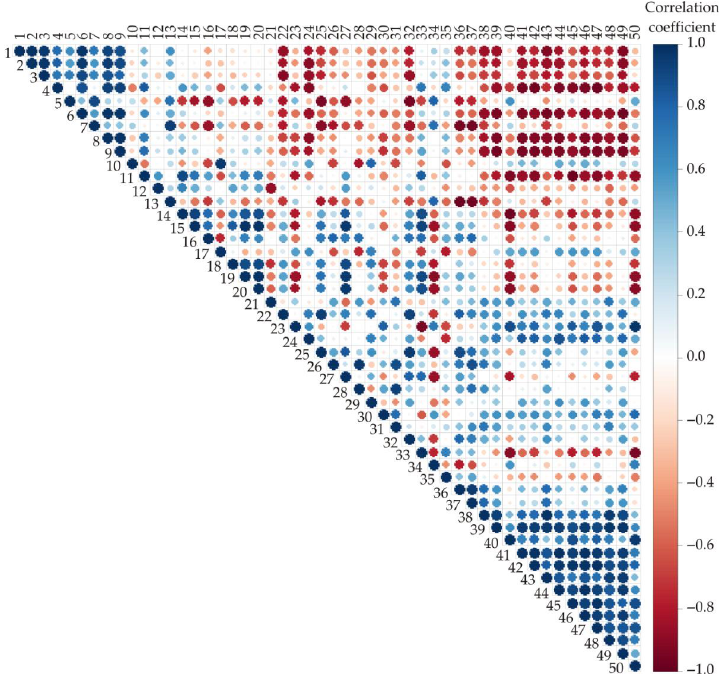
Figure 3. Color correlation diagram of active compounds content in the immortelle EO samples from 2017, 2018, and 2019 (active compounds codes are listed in Table 2). Thoroughly illustrating the observed data structure, PCA was employed, and the ac- quired results are shown in Figure 4. The first two PCs illustrated 78.7% of the total vari- ance in the experimental data. The first PC explained 45.72% and the second 32.98% of the total variance between the experimental data (Figure 4). According to the PCA analysis, a greater positive influence on the first principal com- ponent (PC1) was observed for the content of the following: α -pinene (3.2%, based on cor- relations), α -fenchene (3.2%), β -pinene (2.4%), δ -2-carene (3.9%), limonene (4.0%), γ -ter- pinene (4.1%), terpinolene (4.3%), and isoamyl tiglate (3.1%). The most prominent nega- tive influence on PC1 calculation was observed for the concentrations of the following: trans - α -bergamotene (2.3%, according to correlation), β -costol (2.4%), cis - α -bisabilene (3.3%), trans -nerolidol (4.2%), caryophyllene oxide (2.1%), guaiol (4.2%), rosifoliol (4.2%), epi -1-cubenol (3.6%), γ -eudesmol (4.0%), epi - α -cadinol (3.8%), β -eudesmol (4.1%), selin-11- en-4- α -ol (4.1%), β -bisabolol (3.9%), and neryl isovalerate (4.0%).